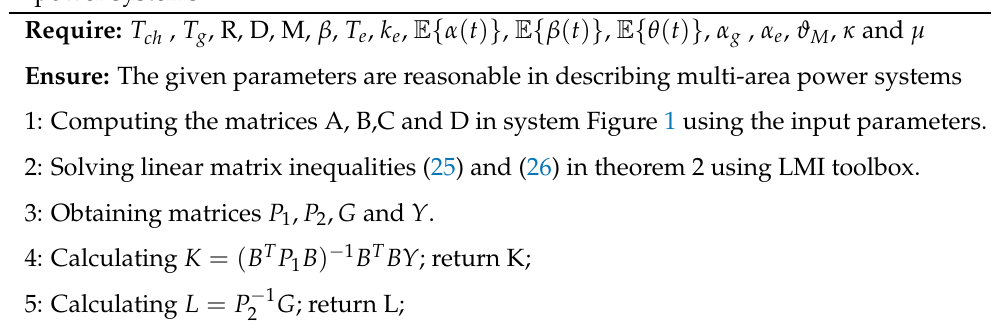
Algorithm 1: Load frequency controller and observer design for networked power